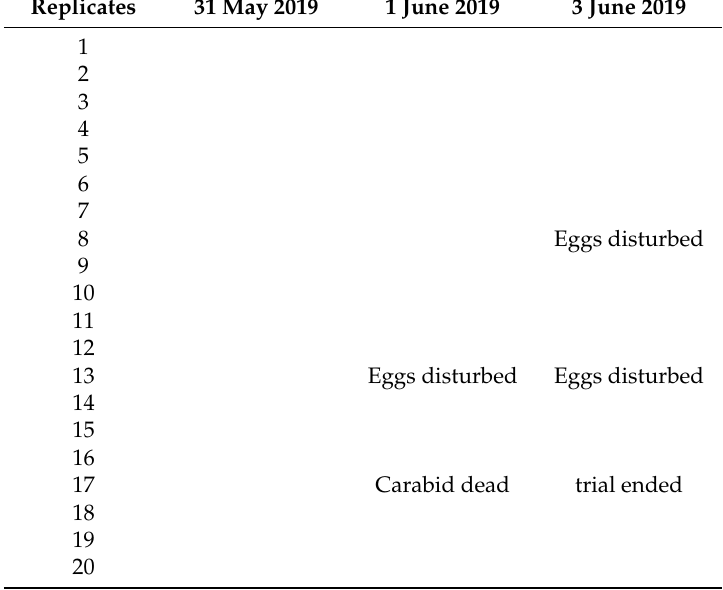
Table A1. Feeding trial 1 with 20 Nebria brevicollis kept at 21 ◦ C and a 12 / 12 light / dark cycle and presented with two Deroceras reticulatum eggs each. The feeding trial was not checked on 2 June 2019.